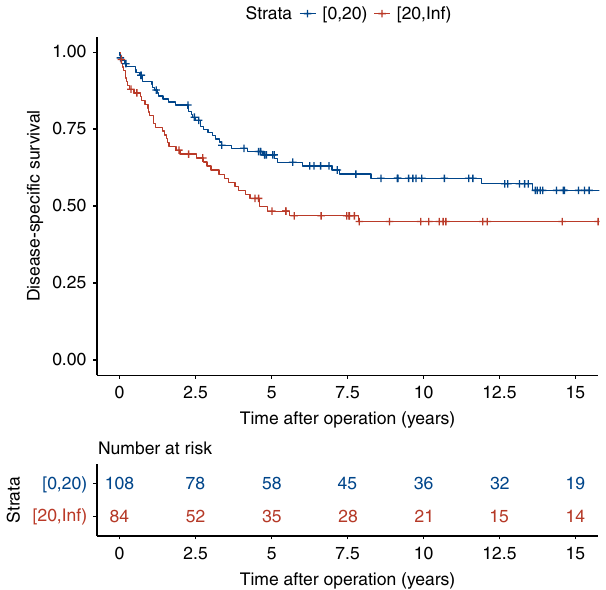
Fig. 6 Kaplan – Meier curves by insertion count. Tumors with less than 20 somatic insertions (blue line) and tumors with 20 or more insertions (red